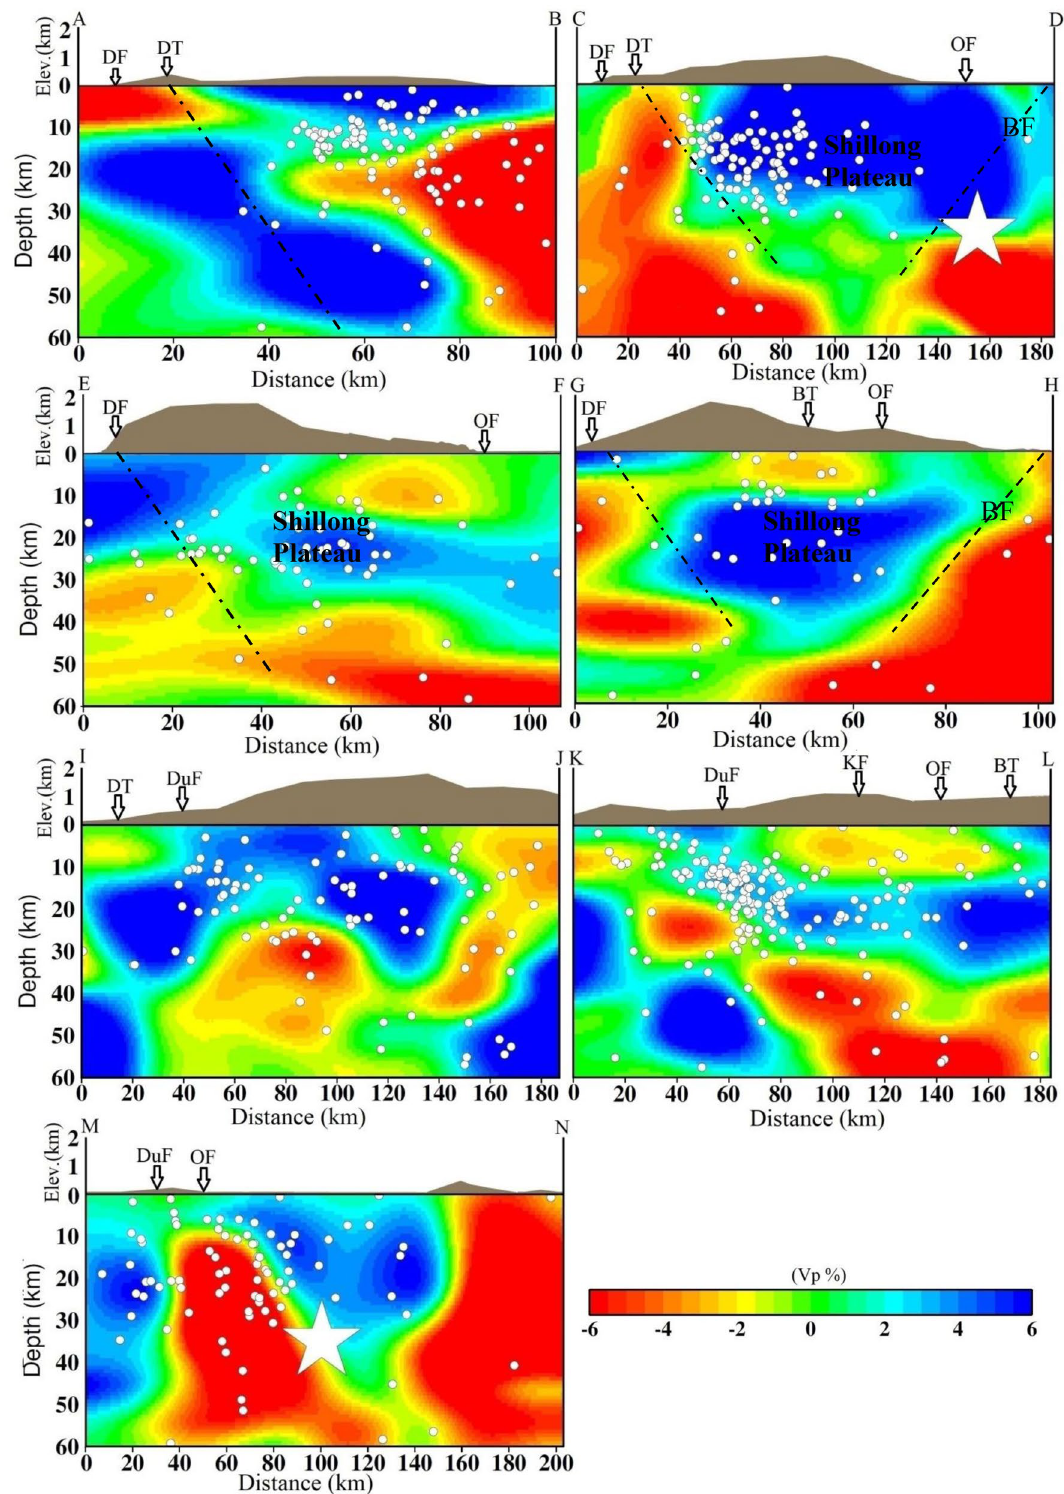
Figure 2. Vertical cross sections of the P-wave velocity models. The positions of the cross sections are shown in Fig. 1. The star shows the 1897 Shillong earthquake (M s 8.7). The geological faults are also